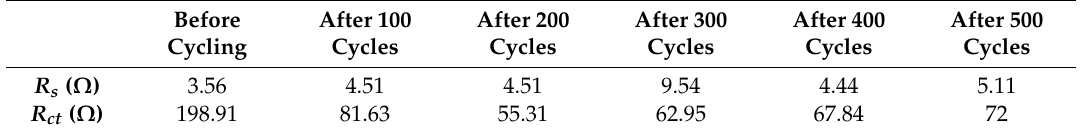
Table 1. Solution and charge-transfer resistances computed from equivalent circuit at different cycles. Before After 100 After 200 After 300 After 400 After 500 Cycling Cycles Cycles Cycles Cycles Cycles R s ( Ω )